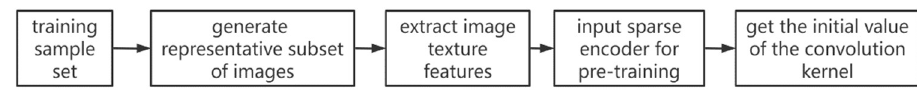
Figure 2. The process of the method.